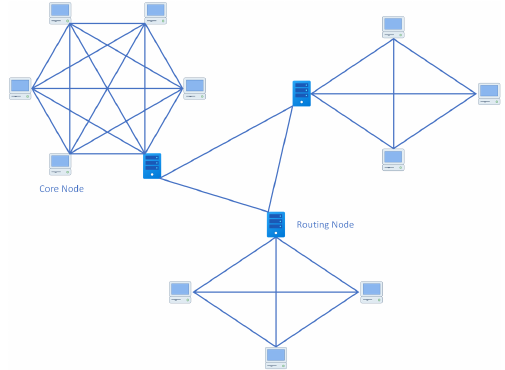
Figure 6. Clustering of Peers by Hao et al.